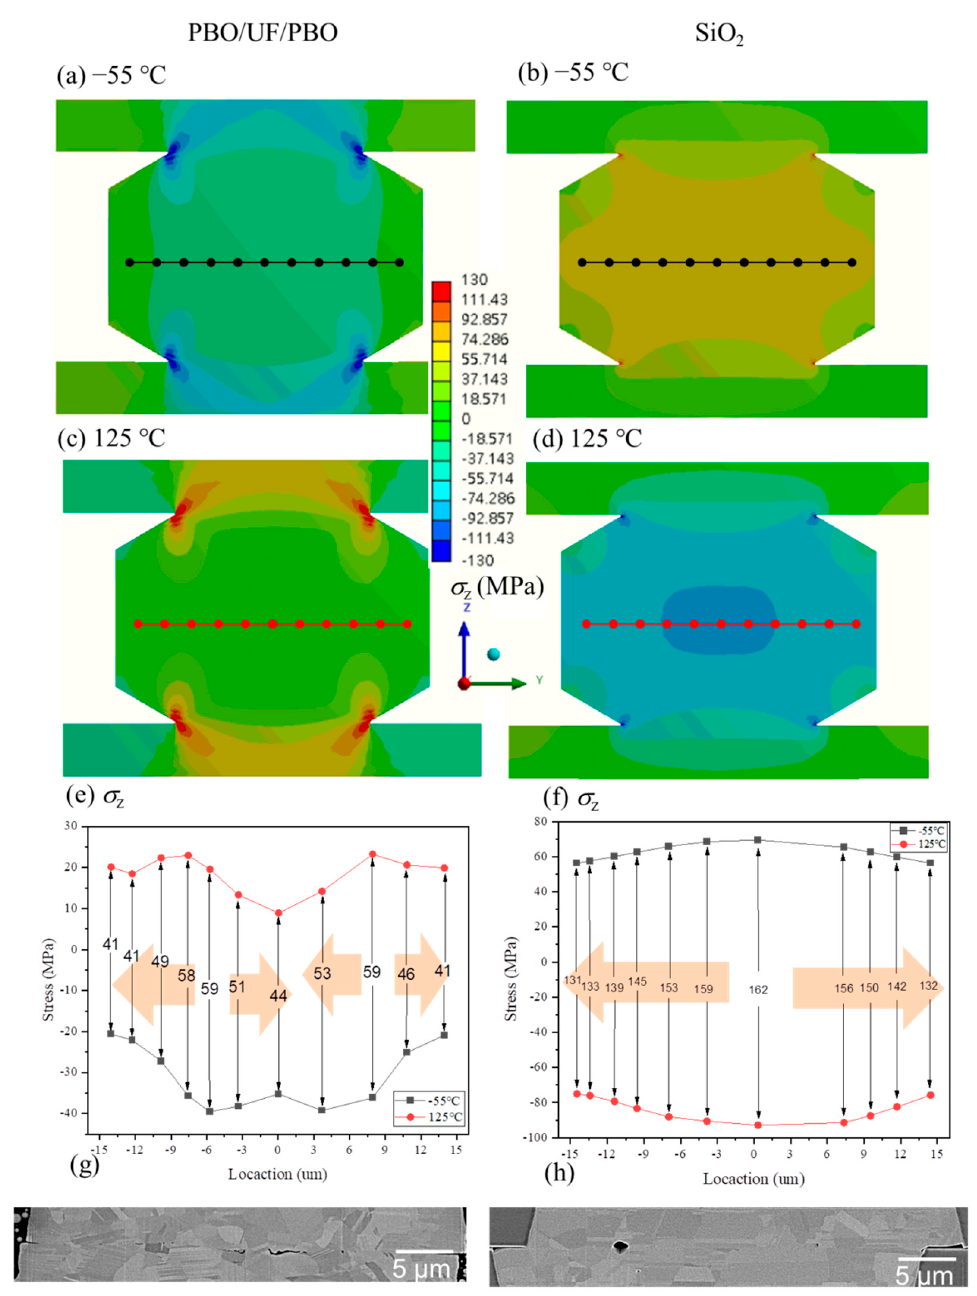
Figure 4. Stress distribution ( σ ζ ) in the 3D FEA joints at temperatures − 55 °C and 125 °C with two different dielectric structures: PBO/UF/PBO ( a , c , e ) and SiO 2 ( b , d , f ), respectively; ( g , h ) are the corresponding FIB images of the joints after the thermal cycling tests.